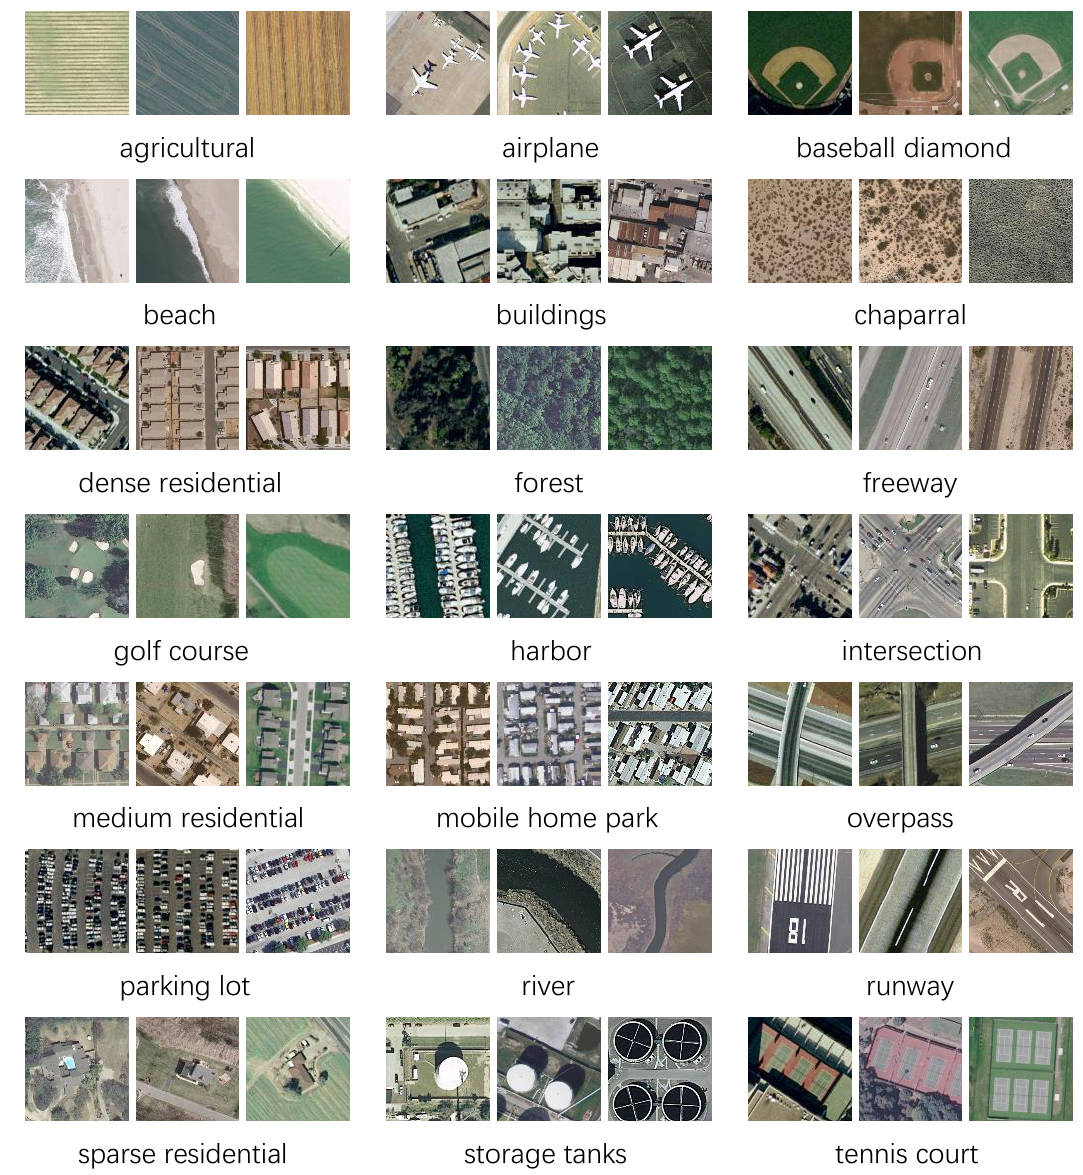
Figure 8. Some sample images from the UC Merced Landuse data